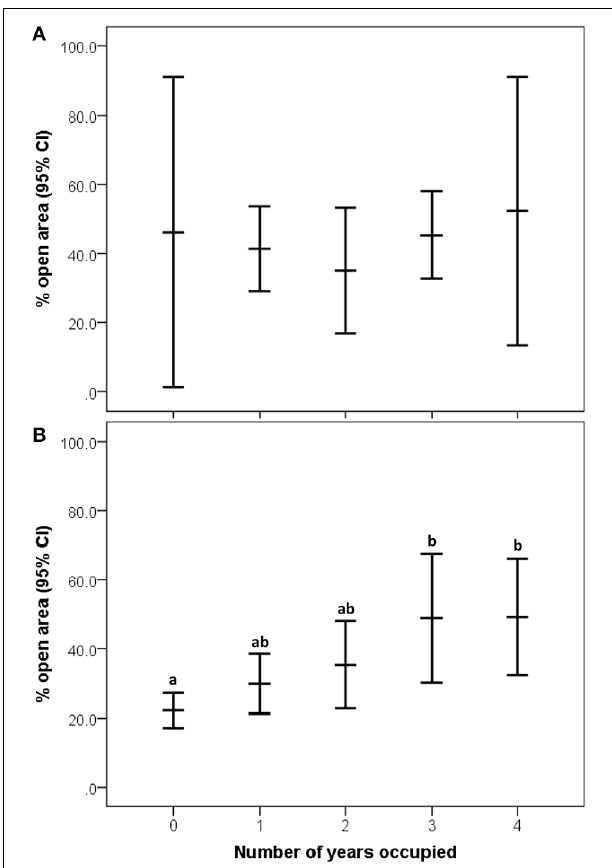
FIGURE 4 | Relationship between level of competition (high vs. low) with tree swallow and (A) bluebird occupancy ratios (the percentage of time a territory is occupied since establishment) and (B) percentage of open area (grassland/agriculture). There is a greater portion of % open area per territory and higher occupancy at nest boxes in areas of low interspecific